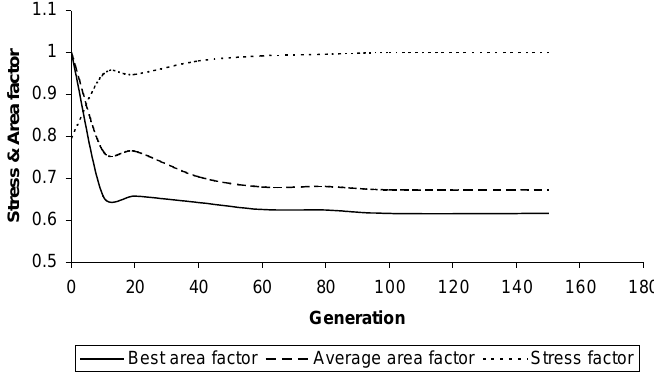
Fig. 8. Genetic evolution of stress and area factor (cantilever beam).